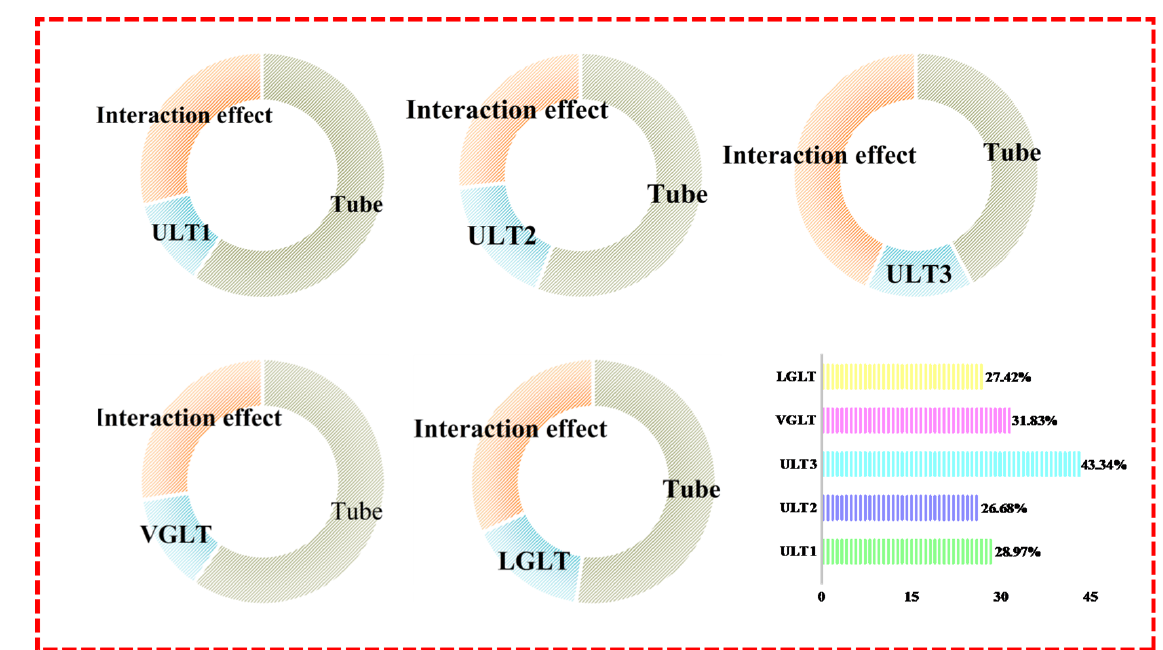
Figure 14. Contribution of energy uptake.